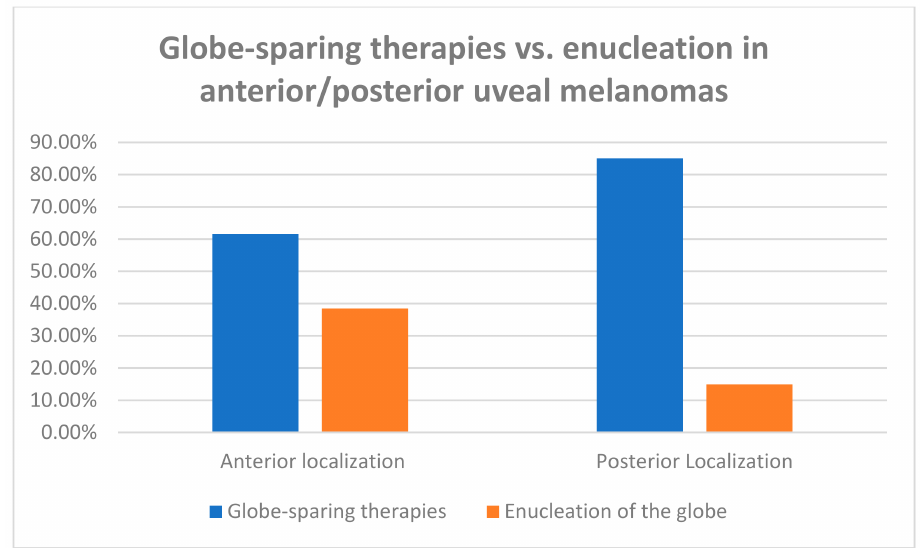
Figure 3. The treatment methods of uveal melanoma according to intraocular anterior/posterior localization of the tumor at the time of cancer diagnosis. Chiˆ2 Pearson test p <